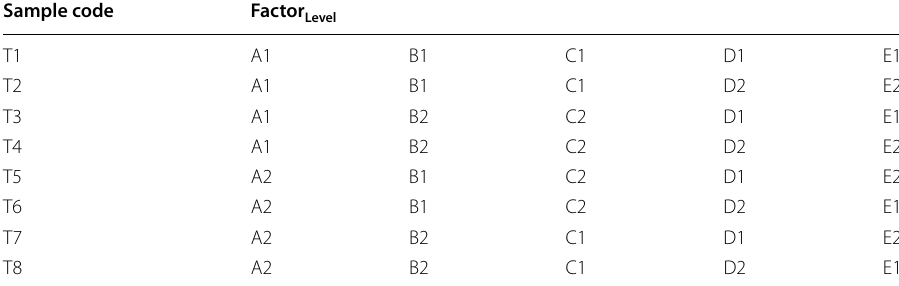
Table 3 Taguchi matrix Sample code